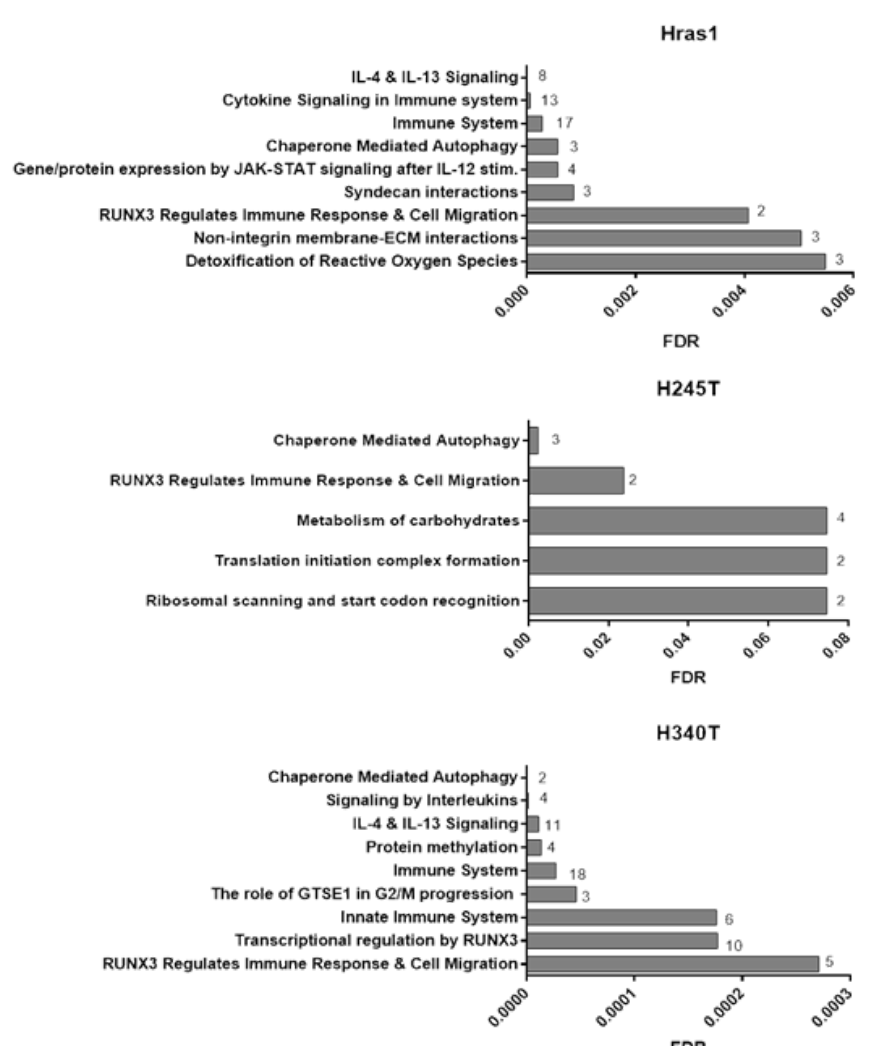
Figure 7. Proteomic analysis of conditioned media from HrasG12V/Pten − / − / TPO-Cre thyroid cell lines. Pathway analysis results comparing secretions from HrasG12V/Pten − / − / TPO-Cre thyroid cell lines (Hras, H245T, H340T) and wildtype thyrocytes. Reactome pathway database was queried for